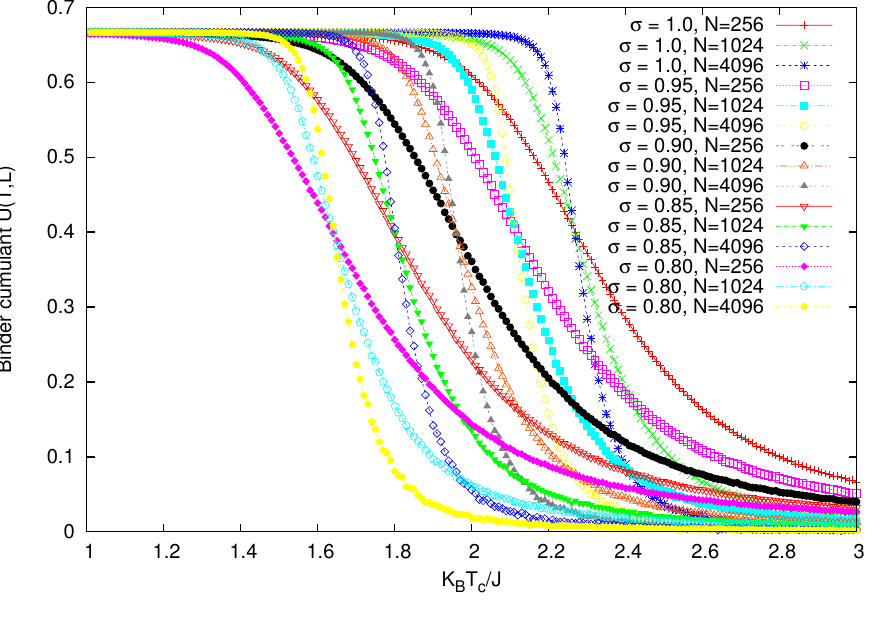
Fig. 3. The Binder cumulant U ( T , L ) versus the temperature